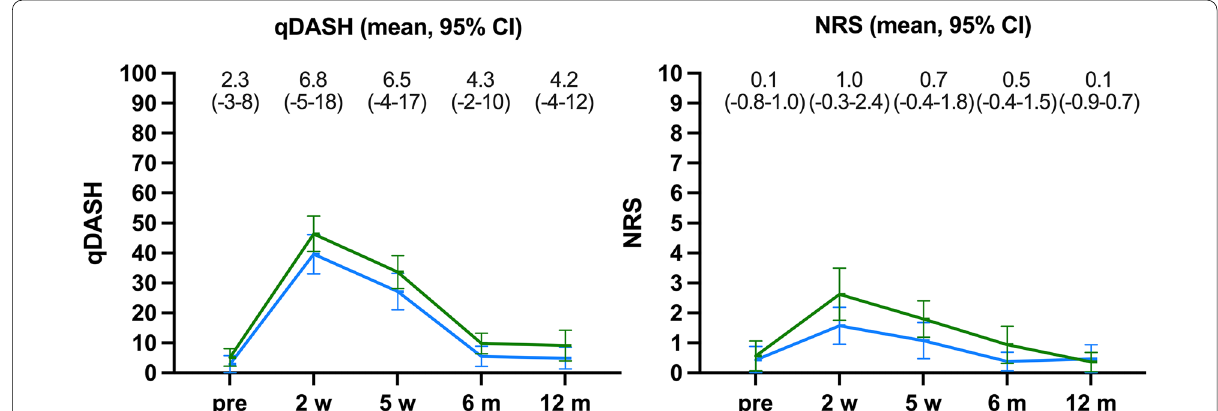
Fig. 3 Functional outcome. Mean qDASH and NRS with 95% confidence intervals as error bars are depicted pre-injury ( pre ) and after 2 and 5 weeks ( w ) and 6 and 12 months ( m ). The mean difference (95% confidence interval) between the operative group ( blue ) and the non-operative group ( green ) is given above the